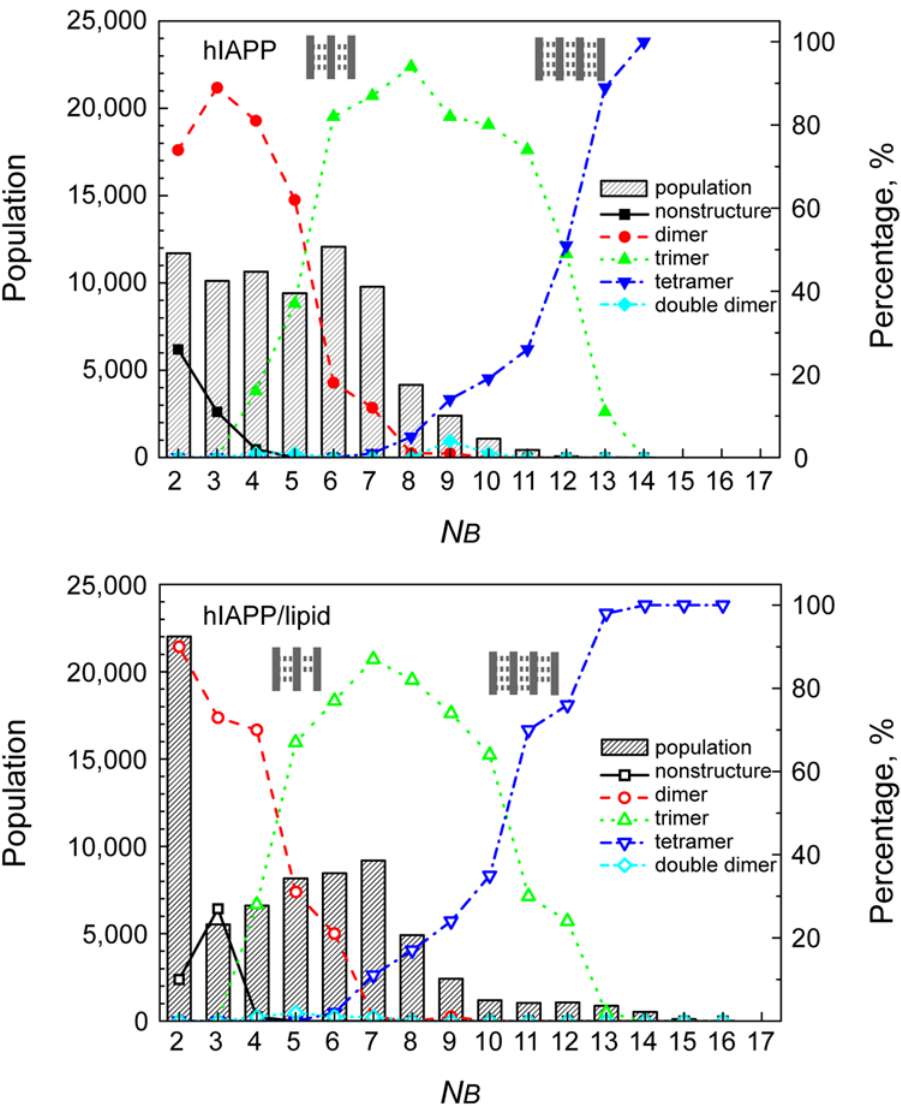
Figure 7. Population (in bars) and percentage of different oligomer sizes (in lines and symbols) of ensembles with fixed value of N B .